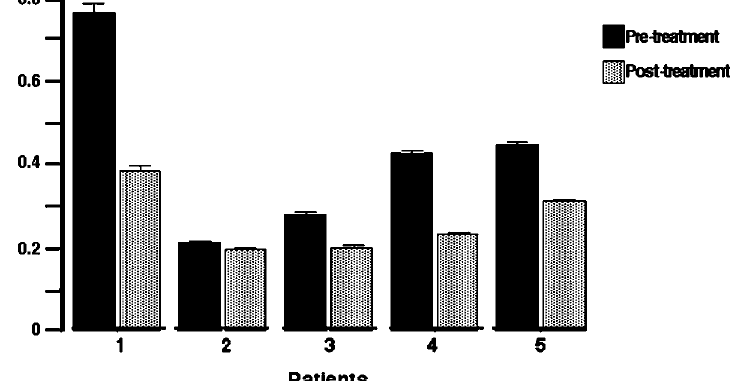
Figure 3. Histone deacetylase activity. The five patients assayed showed a reduction in enzymatic activity. In Y axis are the absolute values in optical density (OD) units. Higher and lower decreases were 0.3845 and 0.0175, for a mean decrease of 0.1624. This difference was statistically significant (p=0.042).